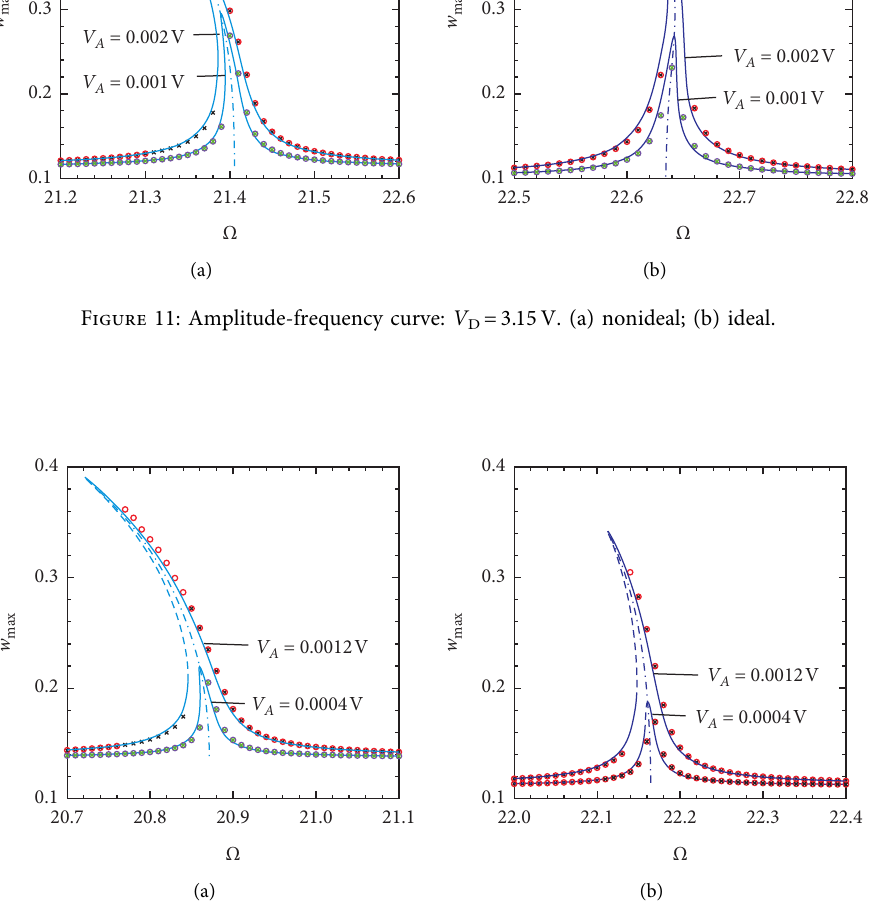
� 3.4V. (a) nonideal; (b) D